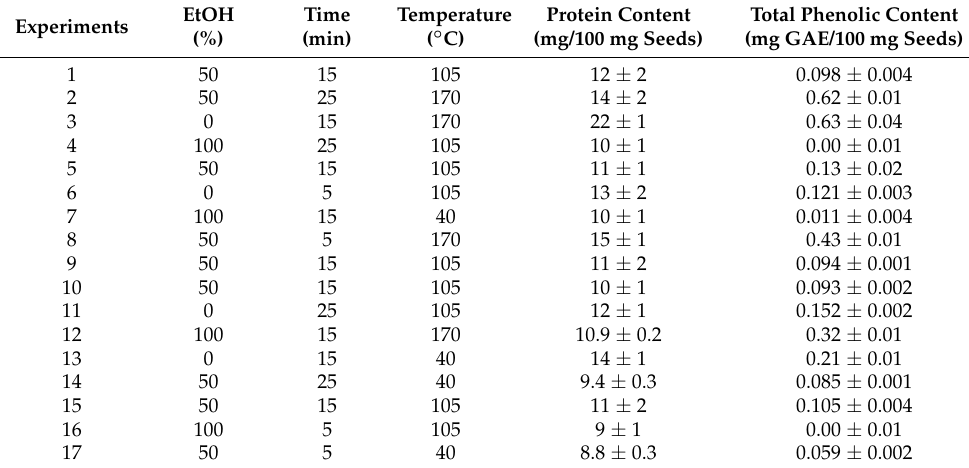
Table 1. Experiments established by Box–Behhken experimental design for the optimization of the percentage of EtOH, temperature, and time in PLE and protein content and TPC determined in the obtained